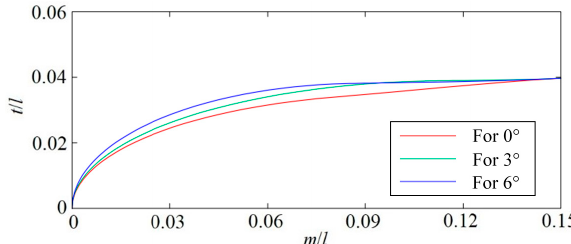
Figure 5. Schematic diagram of the optimal foil LE shape for 0, 3, and 6 degrees.